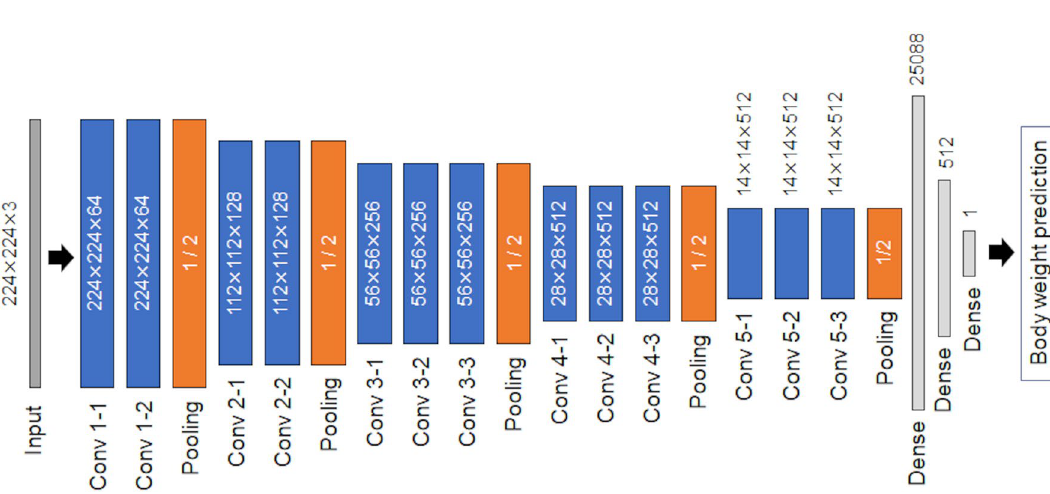
Figure 1. Block diagram of a convolutional neural network-based method for body-weight estimation.